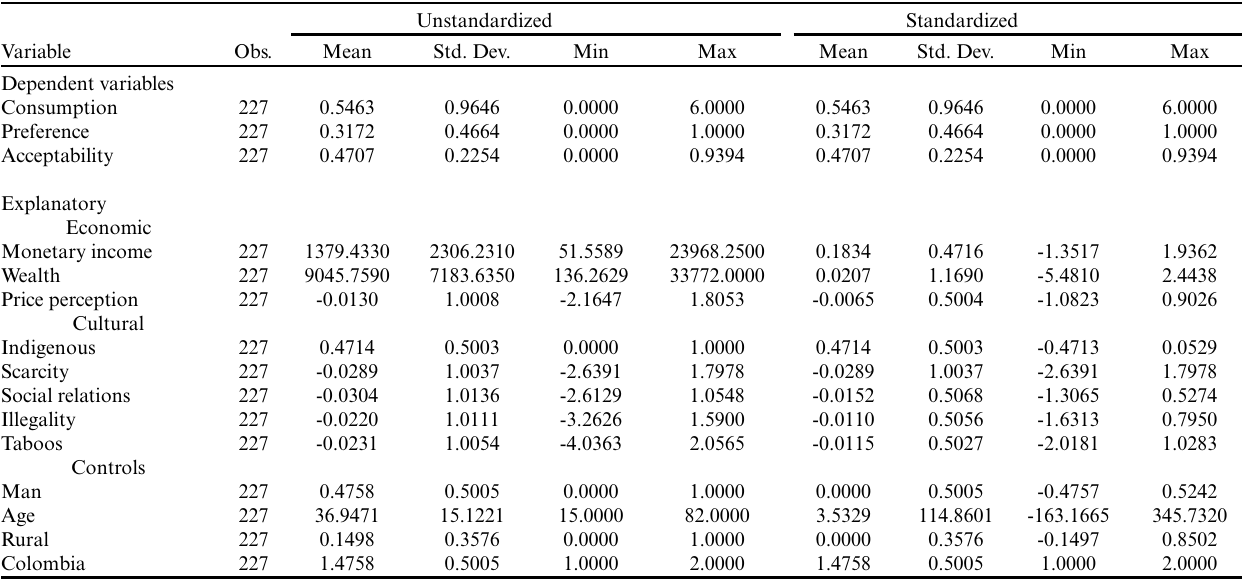
Table 2 . Definition and summary statistics of variables used in regressions (n =